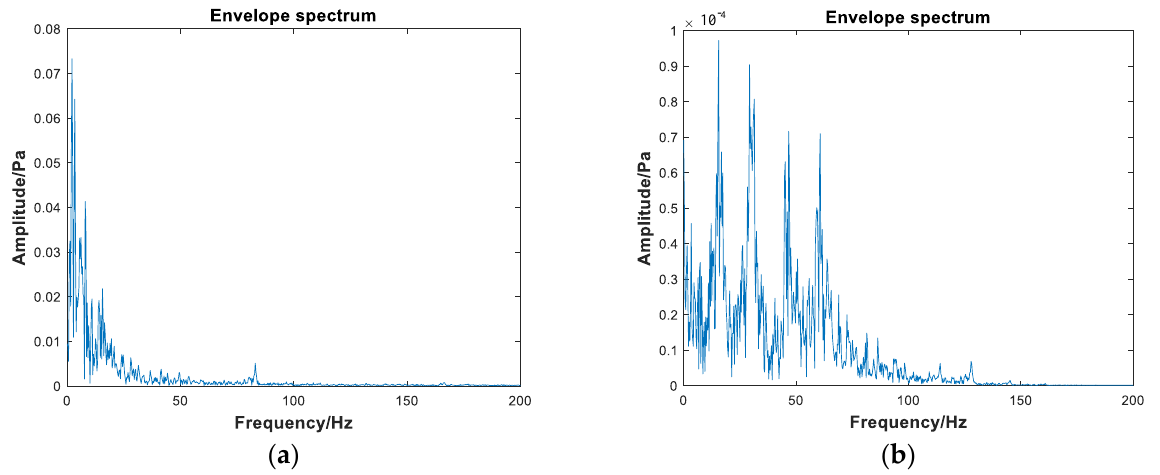
Figure 13. ( a ) Envelope spectrum of the Robinson R44 helicopter before filtering at 17.75 km; ( b ) Envelope spectrum of the Robinson R44 helicopter after filtering at 17.75 km.